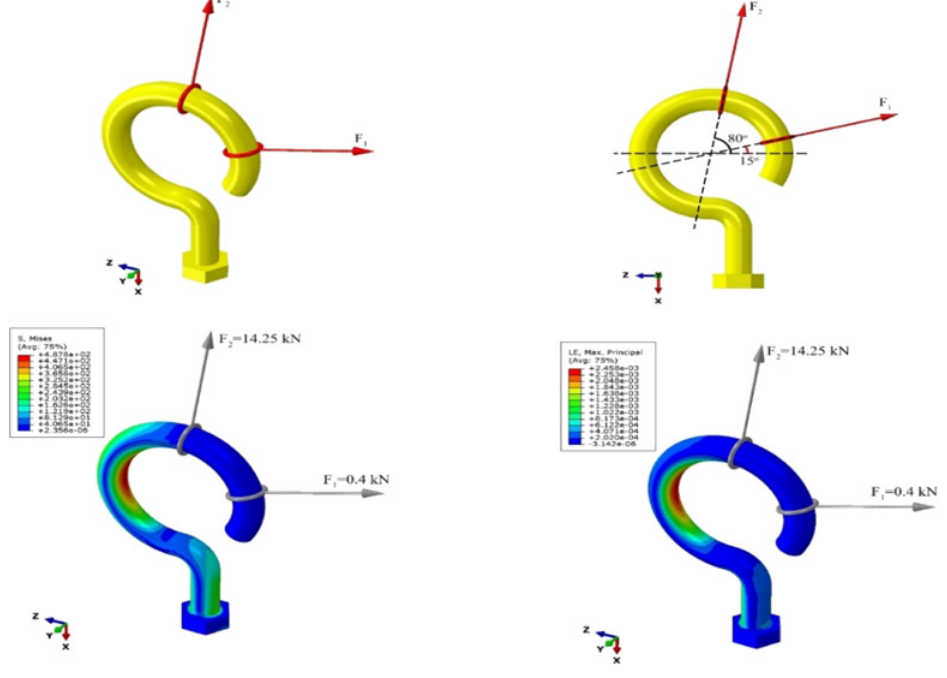
Figure 5 Connections subjected to angular